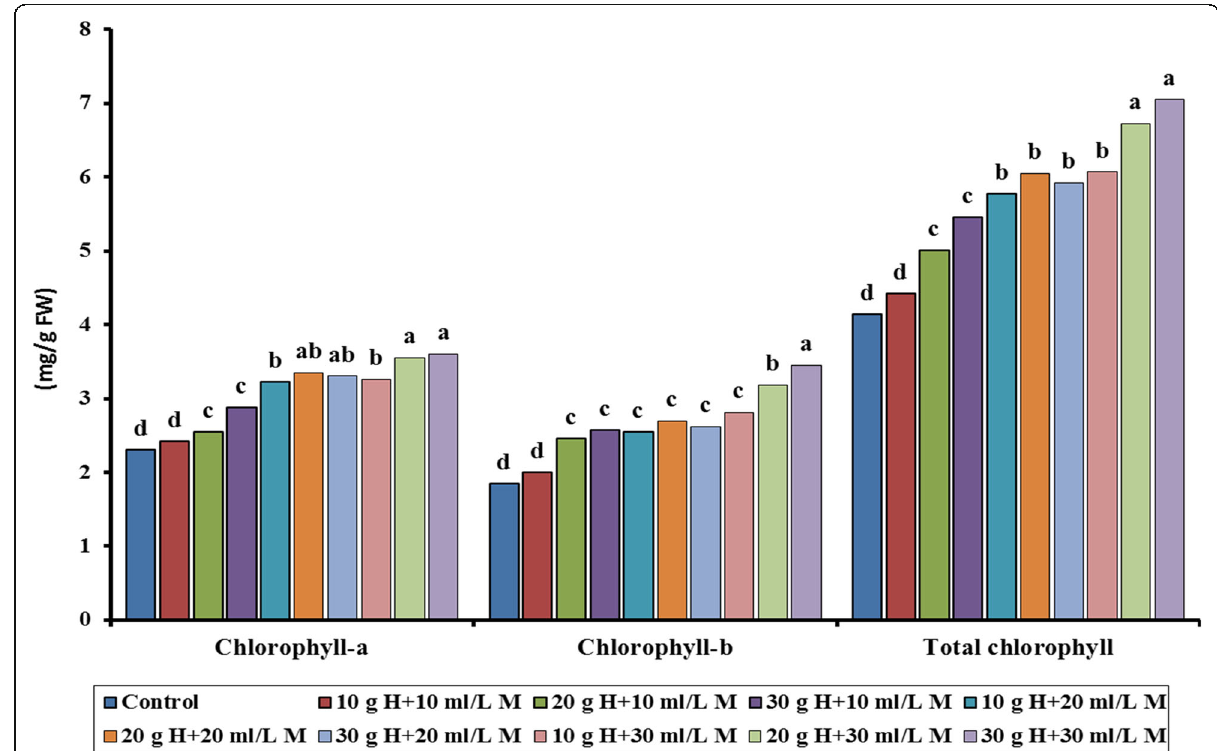
Fig. 2 Effect of soil applications with humic acid and foliar spray of milagro on chlorophyll-a, chlorophyll-b, and total chlorophyll during the second